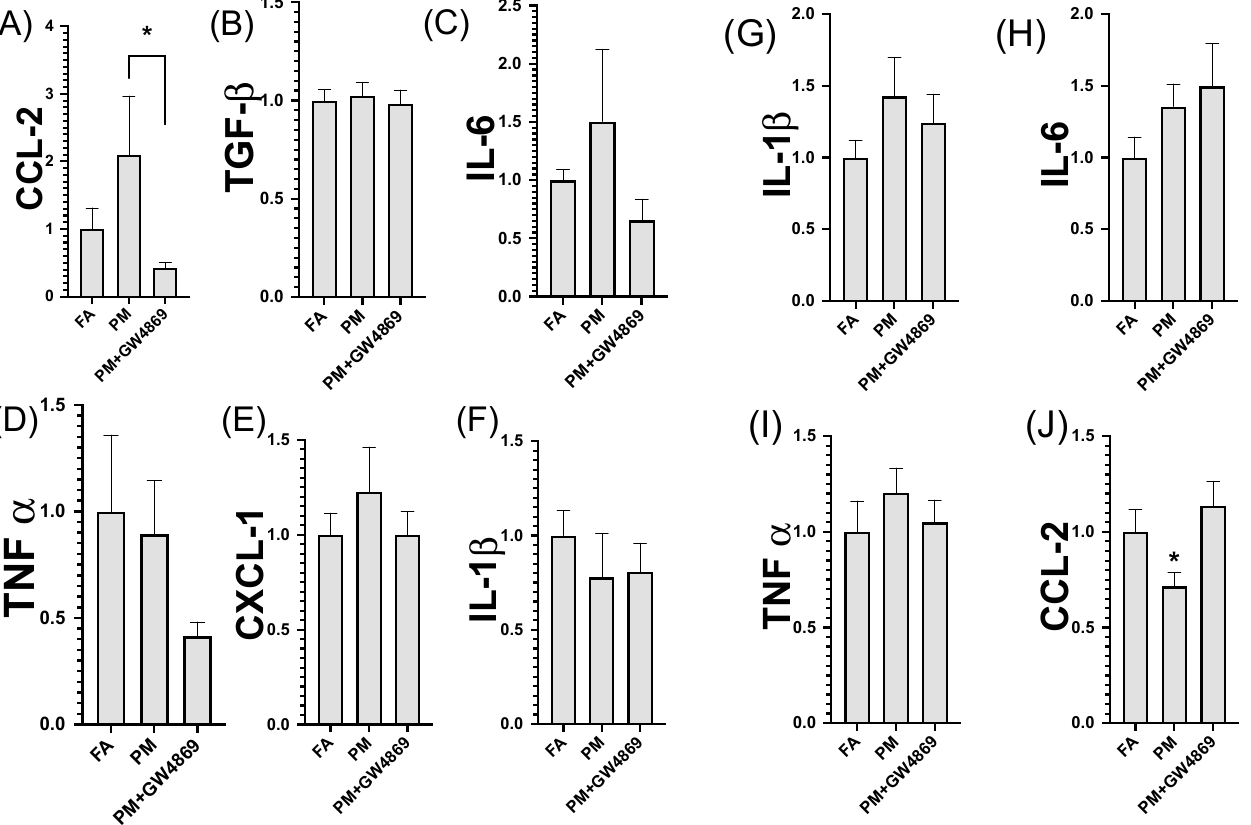
Figure 3. Lung and brain RT-qPCR whole-lung homogenate gene expression for RT-qPCR analysis ( A – F ). Brain homogenate gene expression ( G – J ). Data were statistically analyzed using a one-way analysis of variance test (ANOVA), followed by a Kruskal Wallis post hoc test; p ≤ 0.05 was considered statistically significant, as indicated by the asterisk (*). Data represented include the mean ± SEM.